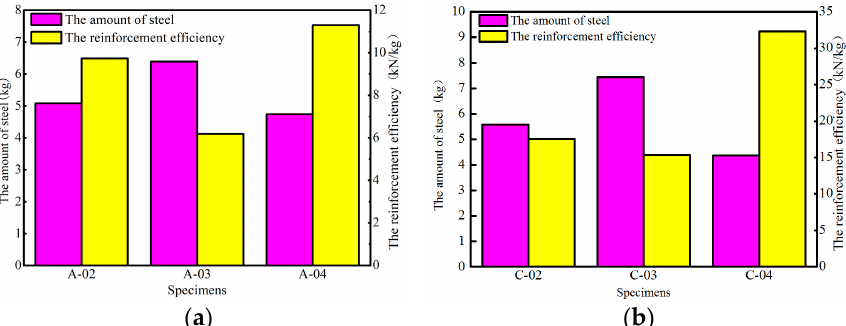
Figure 18. Amount of steel used and the reinforcement e ffi ciency: ( a ) Group A irregular concrete deep beam specimens; ( b ) Group B shaped concrete deep beam specimens.